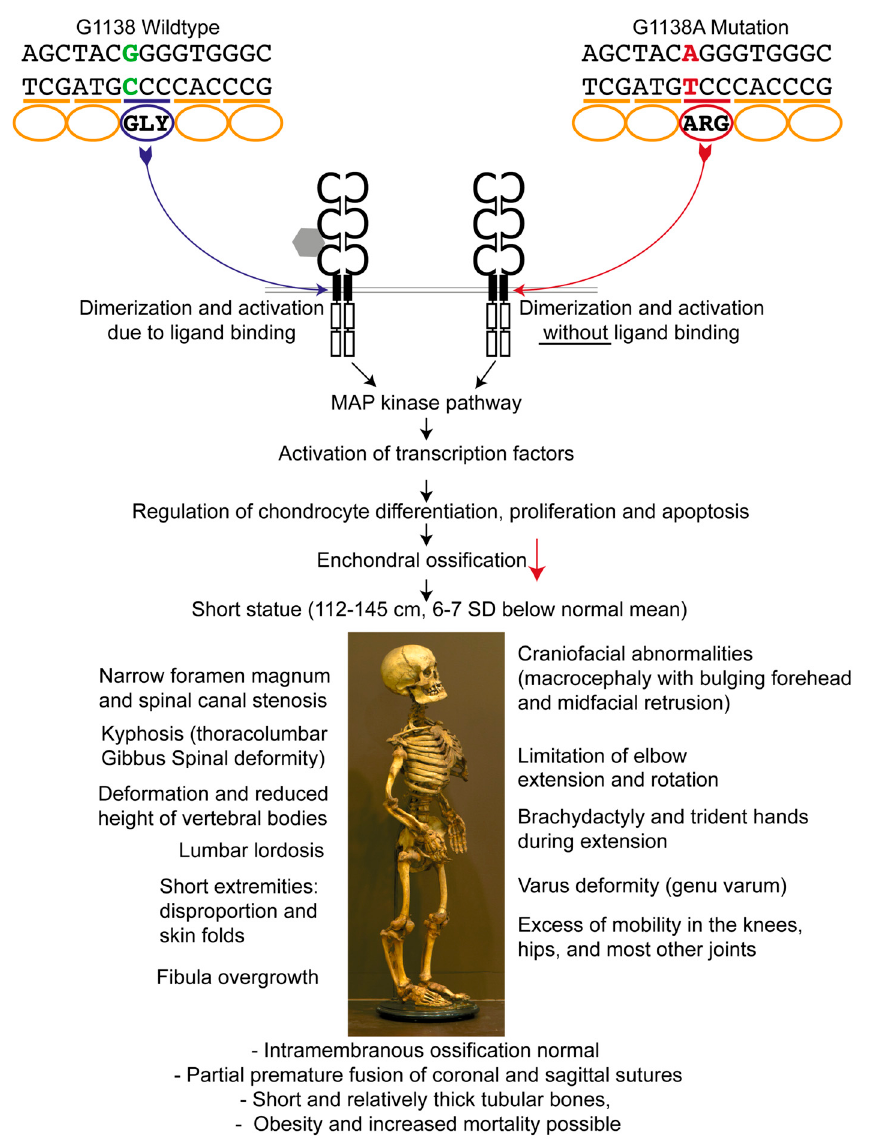
Figure 1. Genetic background and consequences of the fibroblast growth factor receptor-3 gene (FGFR3) mutation. The G1138A mutation leads to an amino acid exchange within the transmembrane region of FGFR3, resulting in a ligand-independent activation of the downstream pathways. FGFR3 is a negative regulator of enchondral ossification. In the case of a mutation, increased protein activity and thereby dramatically decreased enchondral ossification with normal intramembranous ossification leads to the observed anomalies in achondroplasia [9,16–22]. SD: standard